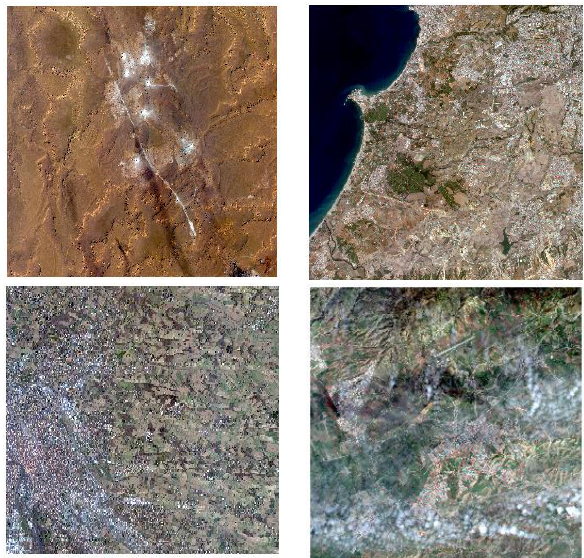
Figure 1. The used Datasets. Top-left : Hassi-Messaoud, Top- right : Algiers,down-left : Toulouse, down-right : Chlef